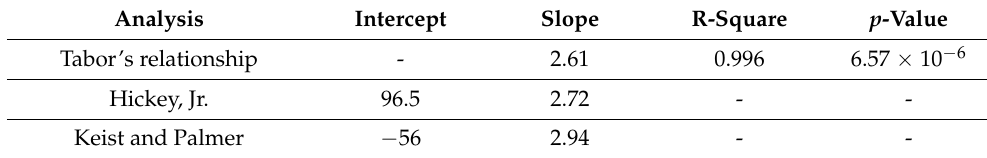
Table 4. Results of the regression analysis based on Tabor’s relationship and from [18,19].